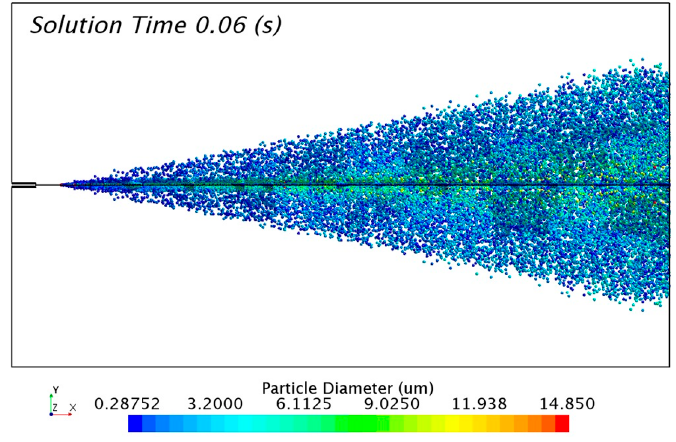
Figure 10. Particle size distribution of the FC75 discrete particles with a driving pressure of 4 bar.